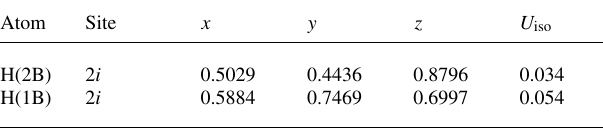
Table 2. Atomic coordinates and displacement parameters (in Å 2 )